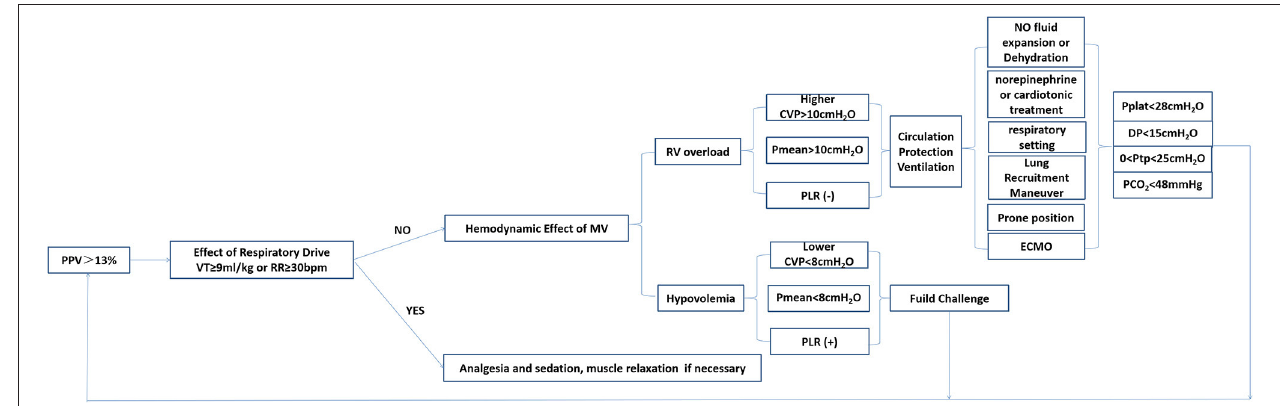
FIGURE 2 | Management and intervention process based on PPV monitoring. PPV, pulse pressure variation; MV, mechanical ventilation; RV, right ventricle; CVP, central venous pressure; P mean , mean airway pressure; PLR, passive leg raising test; ECMO, extracorporeal membrane oxygenation; DP, driving pressure; Ptp, transpulmonary